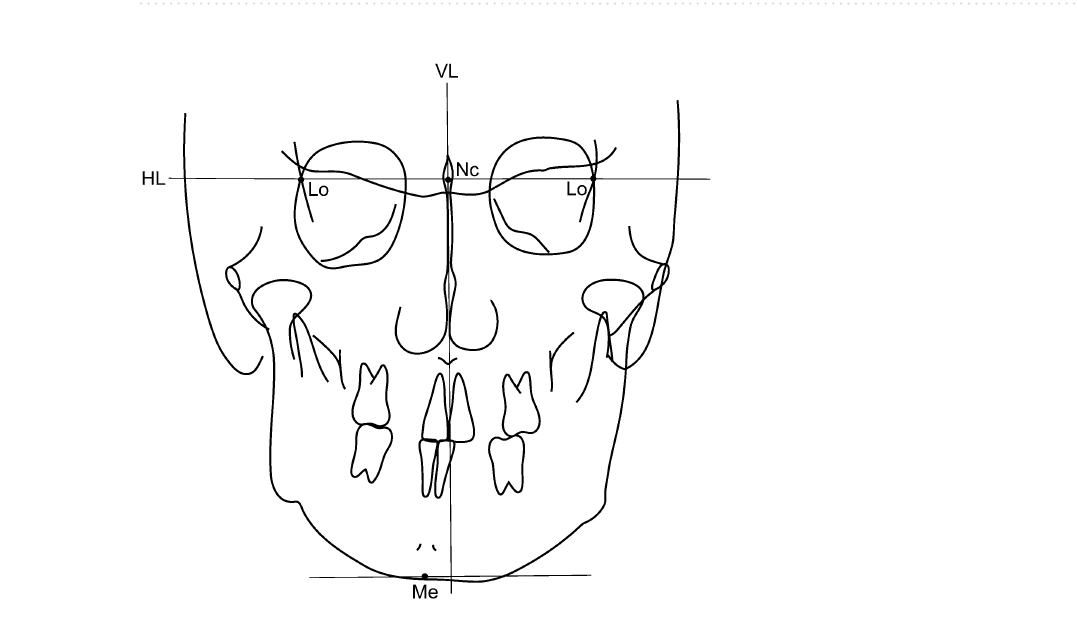
Figure 3. Frontal cephalometric analysis. VL vertical line, HL horizontal